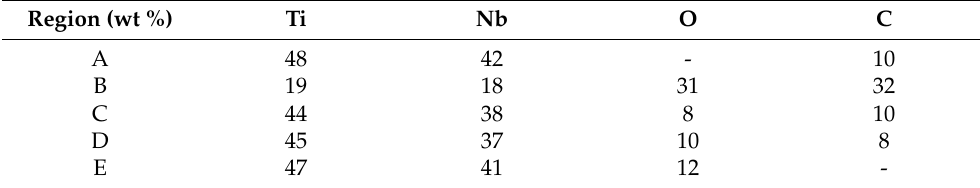
Table 3. Chemical compositions of the wear surfaces detected by EDS in Figure 8. Region (wt